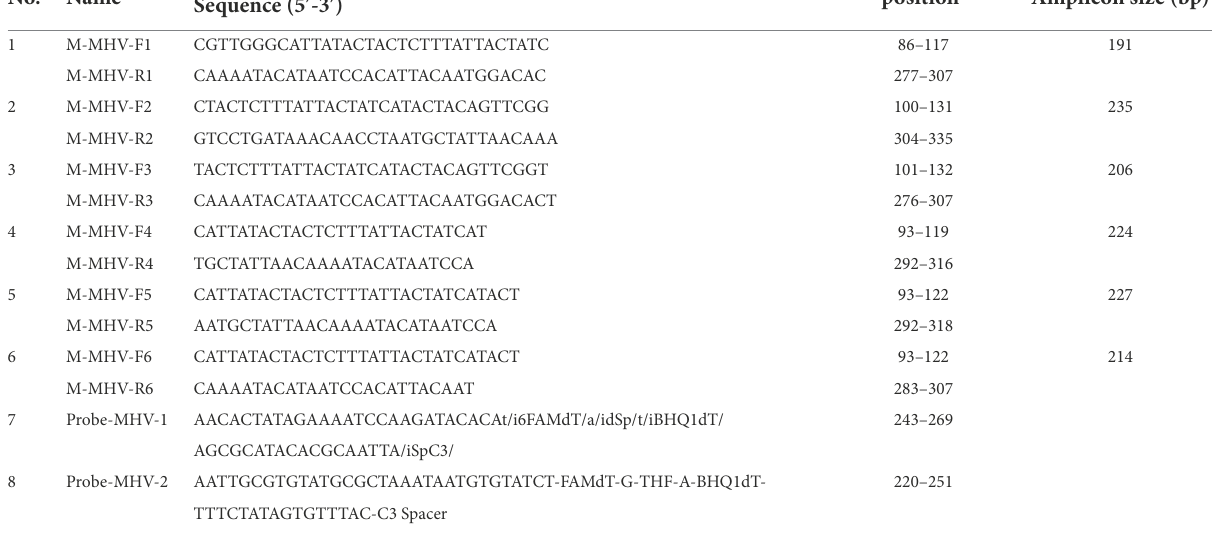
TABLE 1 The sequences of primers and probes used in the RPA